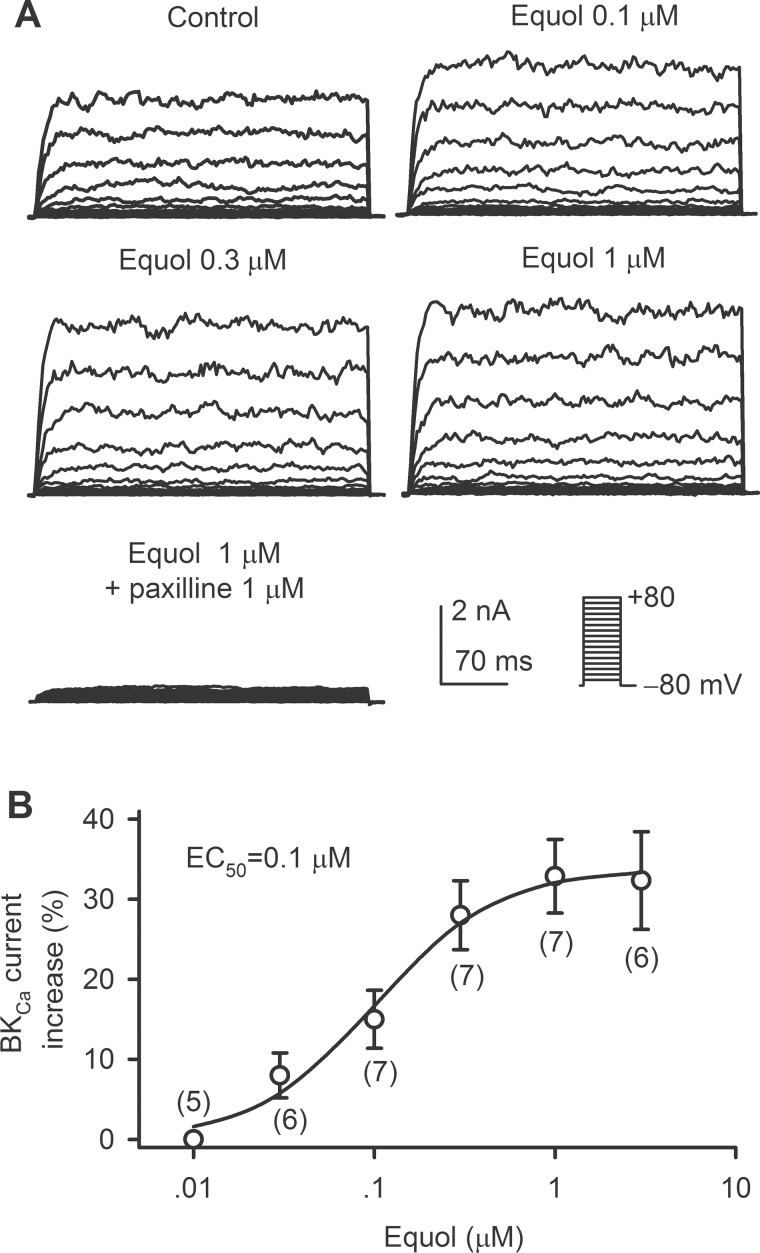
Stimulation of BKCa channels by equol.(A) Voltage-dependent BKCa current recorded in a representative HEK 293 cell stably expressing KCNMA1 and KCNMB1 with voltage protocol shown in the inset in the absence and presence of 0.1, 0.3 and 1 μM equol, and 1 μM equol plus 1 μM paxilline. (B) Concentration-response curve of equol (0.01−3 μM) for stimulating BKCa current at +70 mV was fitted to the Hill equation. The numbers in the parentheses represent experimental number.